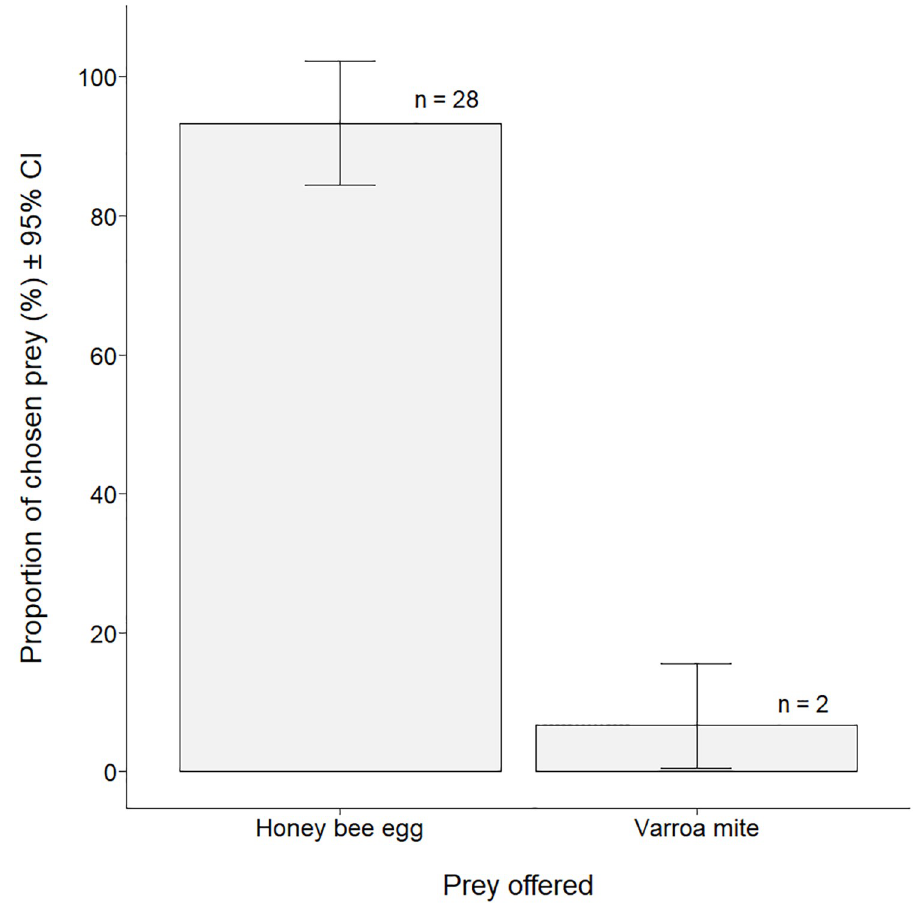
Fig 3. Proportion of honey bee eggs and Varroa mites first chosen by Stratiolaelaps scimitus during a preference test where both prey were offered simultaneously (n = 30) to ten starved S . scimitus individuals.